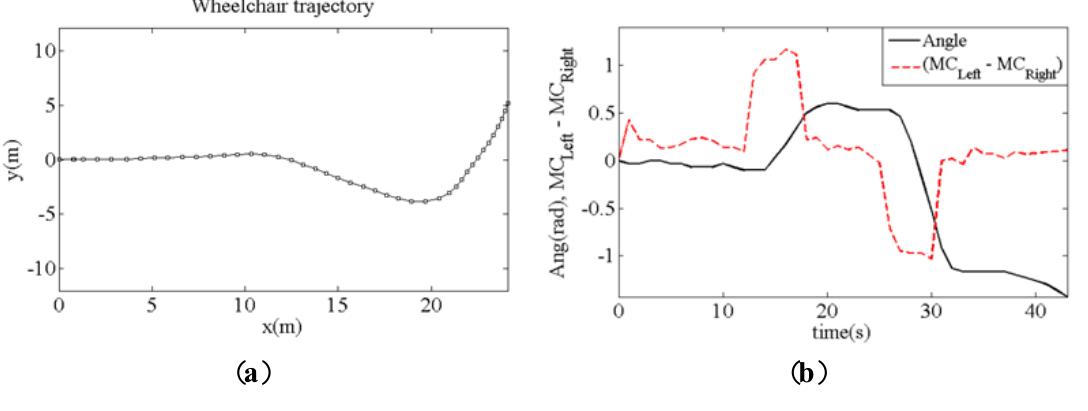
Figure 18. ( a ) Sample trajectory of the wheelchair obtained with odometry and evolution of the center of mass difference (left center minus right center) and ( b ) the turn angle of the chair in